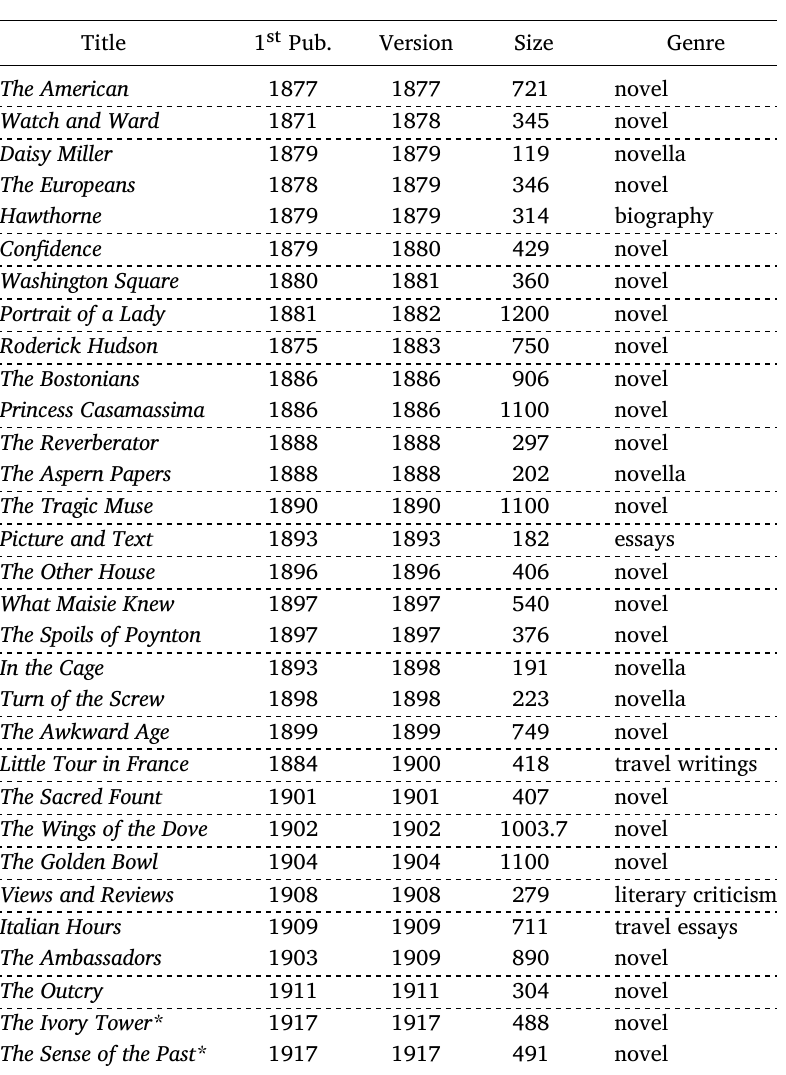
Table 1: Collected works for Henry James. Showing ‘Title’, the original publica- tion date (‘1 st Pub.’), version collected (‘Version’), ‘Size’ in kilobytes and ‘Genre’ type. The dashed lines indicate the boundaries for compression, i.e. which of the works are combined into one temporal interval (see Section 4.3 for discussion of the compression technique